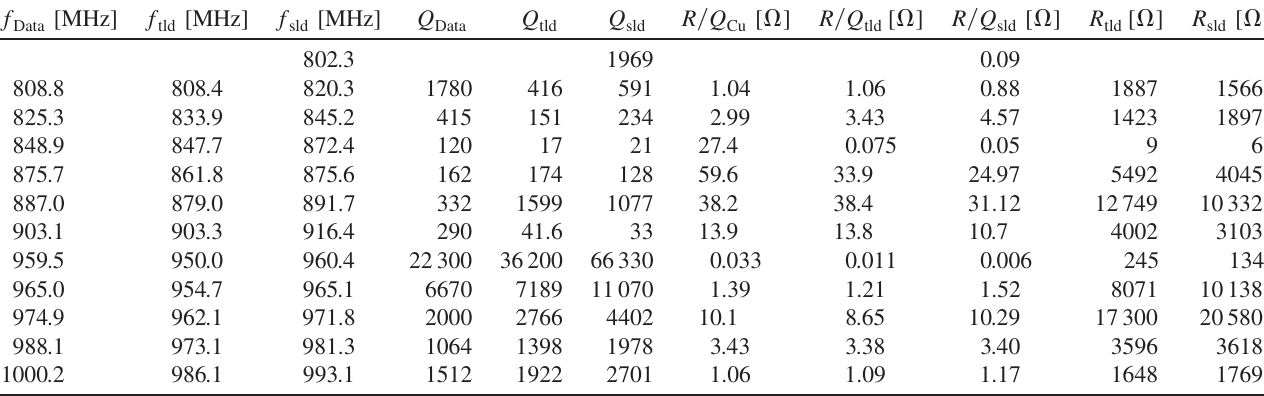
TABLE III. Simulation of Cu cavity with tiled and solid absorber.